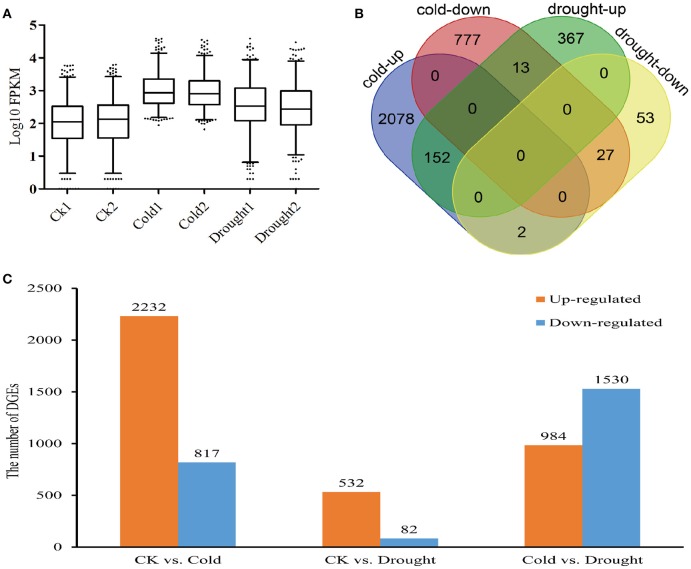
Gene expressions of differentially expressed genes (DEGs). (A) Distribution of Log10(read number) of DEGs in all tested samples. (B) Venn diagram for DEGs in response to cold and drought stress in Zea mays ssp. mexicana L. (C) The numbers of up- and down-regulated unigenes under cold and drought conditions.